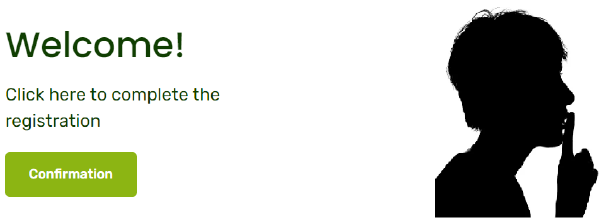
Figure 11. Subscription to SP